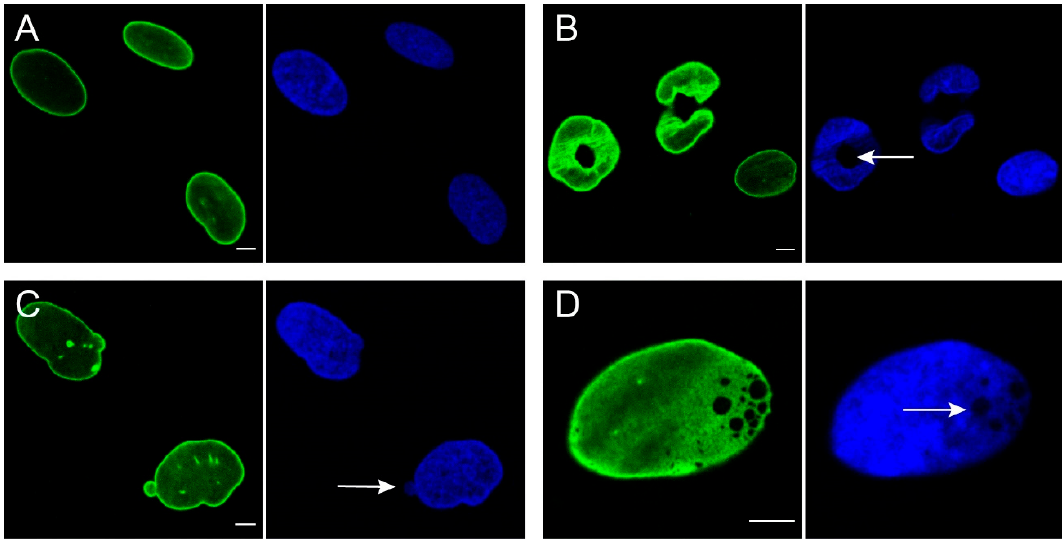
Figure 2. Nuclear abnormalities frequently observed in human dermal fibroblasts from laminopathy patients. Green: lamin A/C staining using Jol2, Blue: DAPI staining of nuclei. ( A ) normal nuclei; ( B ) donut-like shaped nuclei with irregular lamin A/C staining. Note the hole transversing the complete nucleus (arrow); ( C ) nuclear blebbing: nuclear herniations with increased lamin A/C expression. Sometimes, however, lamin A/C expression can be absent in blebs (not shown). Arrow indicates presence of low amount of DNA in bleb; ( D ) honeycomb structures, creating an intranuclear gap (arrow). Bars represent 5 µm.